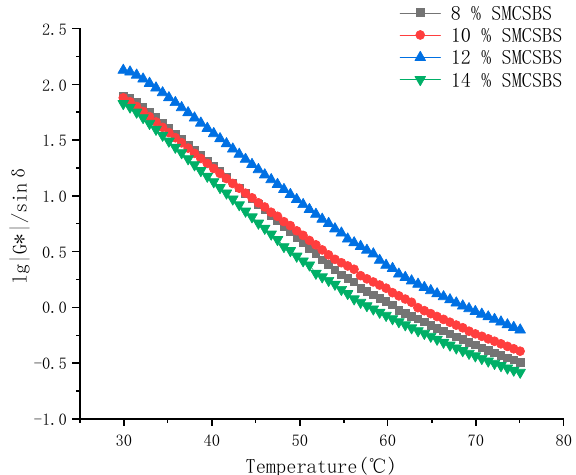
Figure 4. lg ( G */sin δ )-T curve of with different SMCSBS content. According to the regression fitting linear equation, the critical temperature correspond- ing to ( G */sin δ ) = 1 kPa can be obtained, that is, lg ( G */sin δ ) = 0. The results are shown in Table 8. Table 8. The critical temperature of modified asphalt.